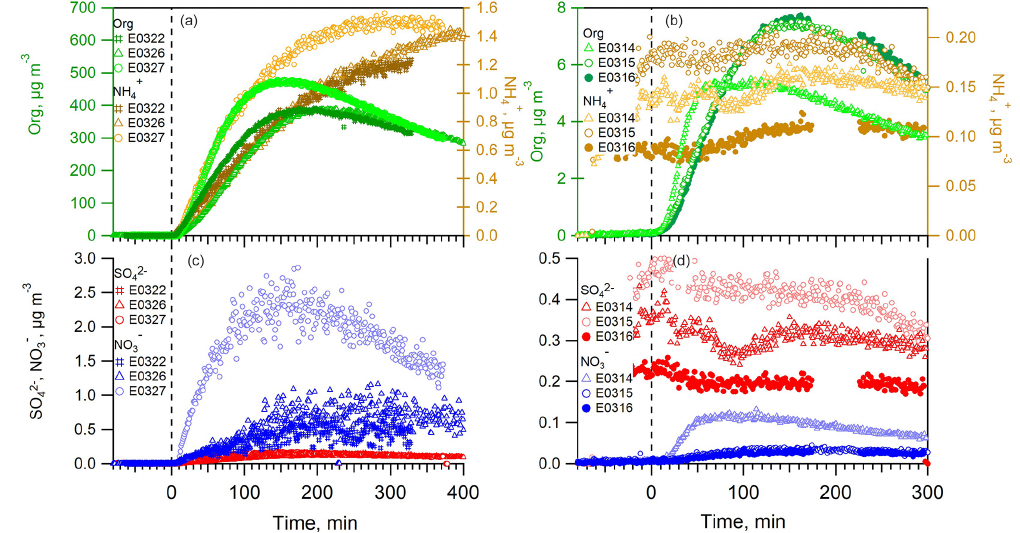
Figure 1. The mass concentrations of organics (left axis), ammonium ( a, b , right axis), sulfate and nitrate (c, d) as a function of irradiation time in nucleation experiments (a, c) and in seeded SOA experiments (b, d) . The irradiation time of 0min marks the start of photooxidation reactions after UV lights were switched